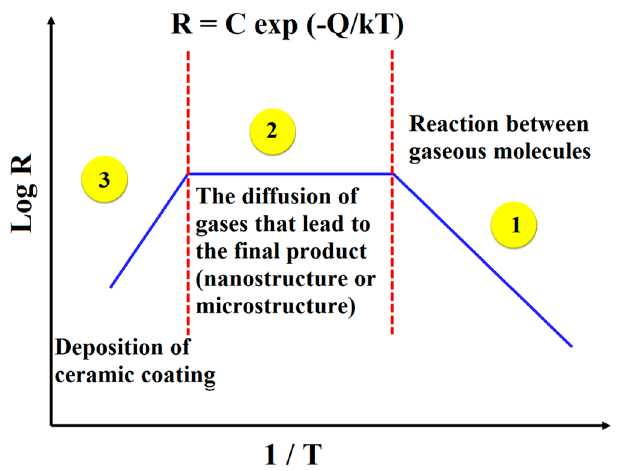
Figure 4. The relationship between kinetic factor (growth rate) and diffusion with temperature during the deposition (ideal indicator chart for coatings deposited in the CVD process).